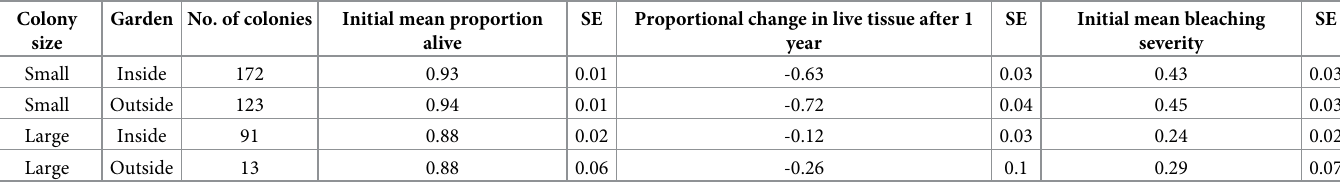
The initial mean ( ± SE) proportion of live tissue, the proportional change in live tissue after 1 year, and the initial bleaching severity for 399 uniquely marked colonies followed for a year post bleaching as a function of coral colony size class (small: � 10 cm dia; large > 10 cm) and farmerfish garden status (inside vs